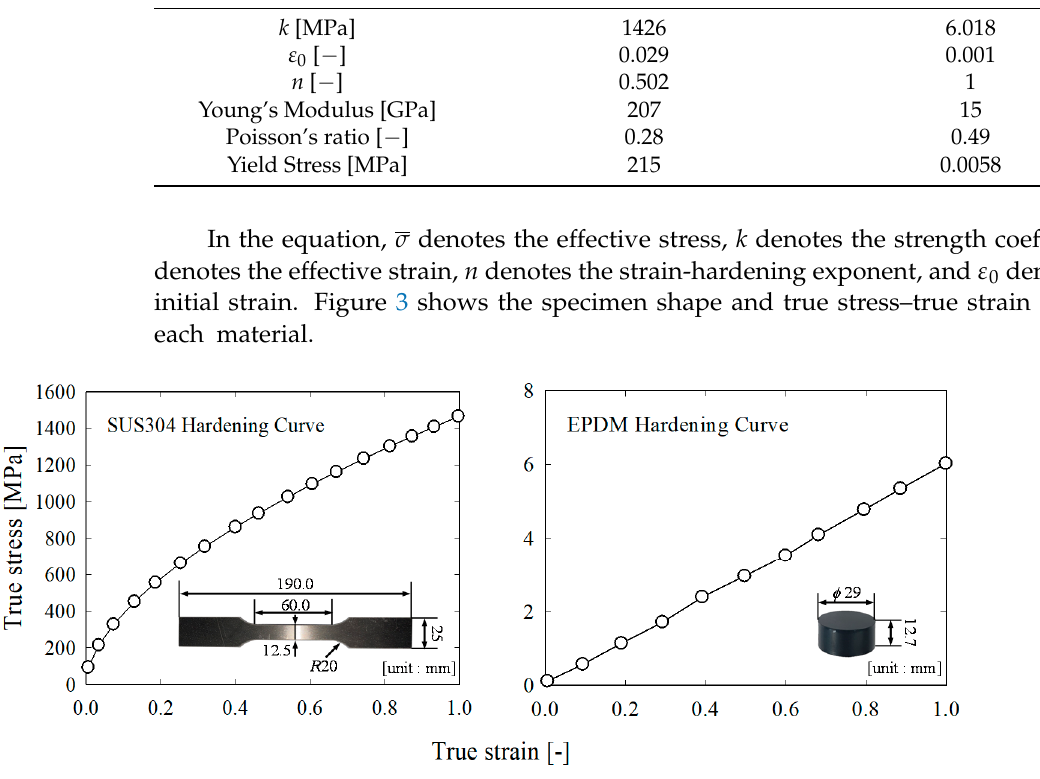
Table 1. Mechanical properties of SUS304 and ethylene propylene diene monomer rubber (EPDM).